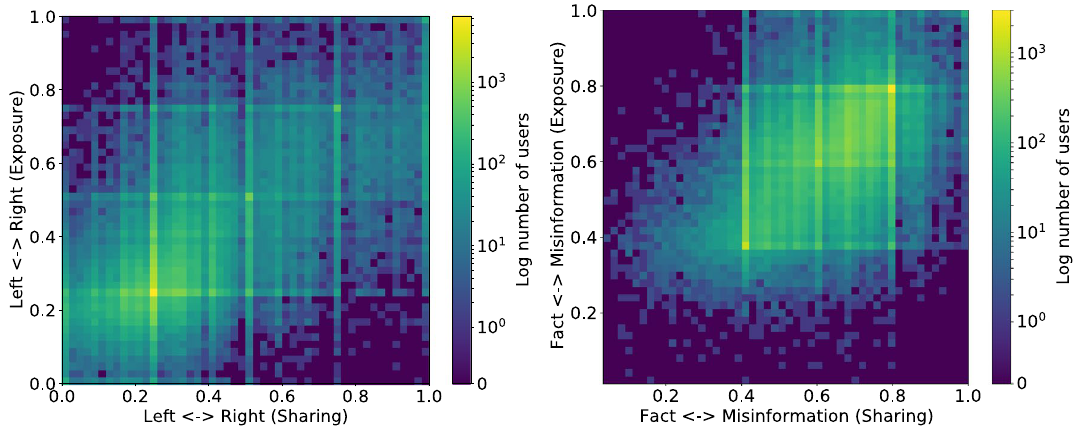
Figure 1. Two-dimensional echo chambers. Heatmap of user polarization scores shows the polarization of information users see and share along ( a ) political (Pearson’s correlation r = 0.61 , p < 0.001 ) and ( b ) factual ( r = 0.50 , p < 0.001 ) dimensions. Colors indicate the number of users given polarization scores.